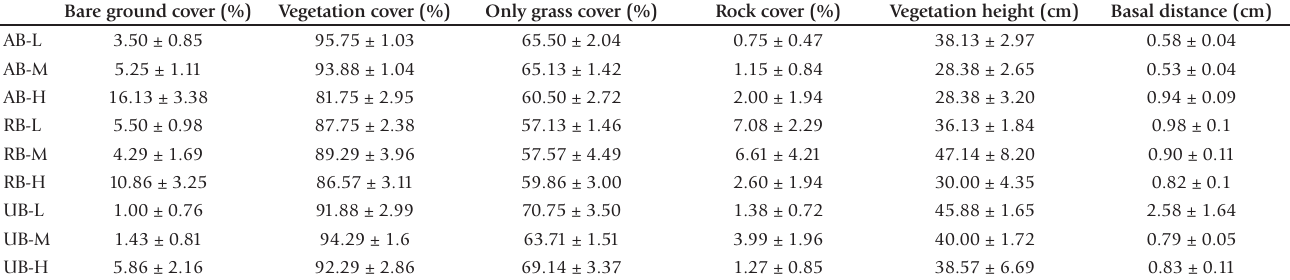
Table 2. Vegetation structure in each disturbance category. Abbreviations for grazing intensity: light (L) in the protected area, and moder- ate (M) or heavy (H) in the ecological network. Abbreviations for fire regime: annual burning (AB), grasslands with longer fire rotation that were recently burned (RB; i.e. burned <12 months prior to sampling) and unburned (UB; i.e. burned >12 months prior to sampling). Bare ground cover